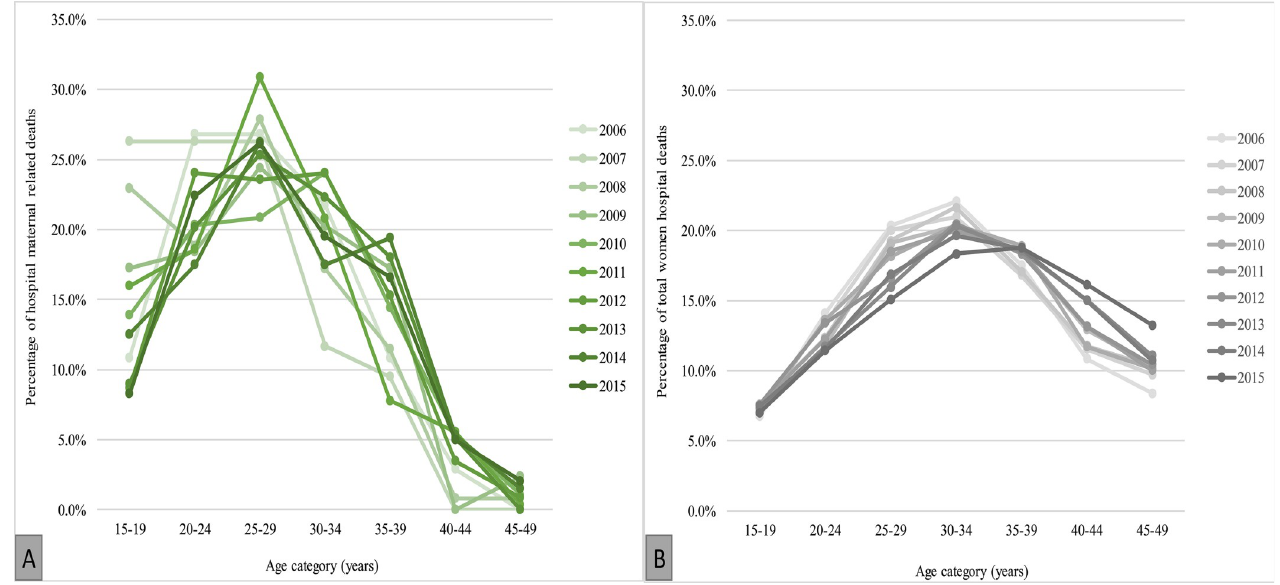
Fig 2. The percentage of hospital maternal associated deaths (A) and percentage of total women in-hospital deaths (B) by age category.